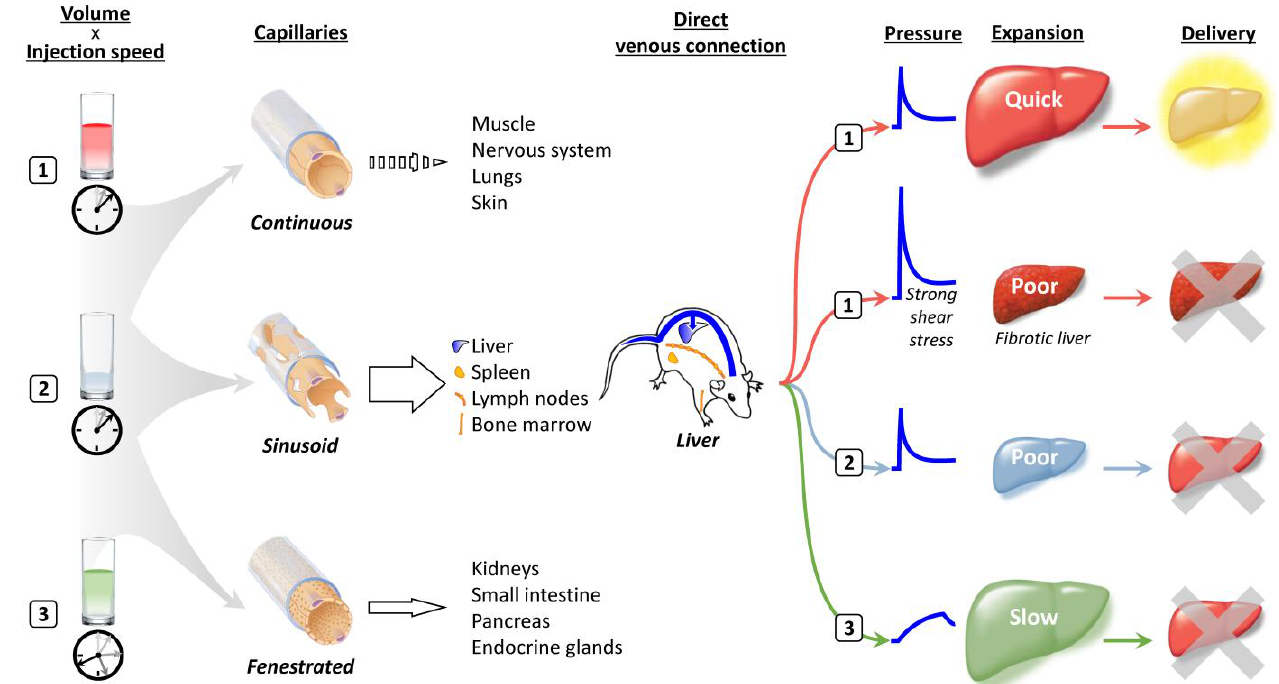
Figure 1. Traverse of hydrodynamic impact from injection to gene transfer sites.